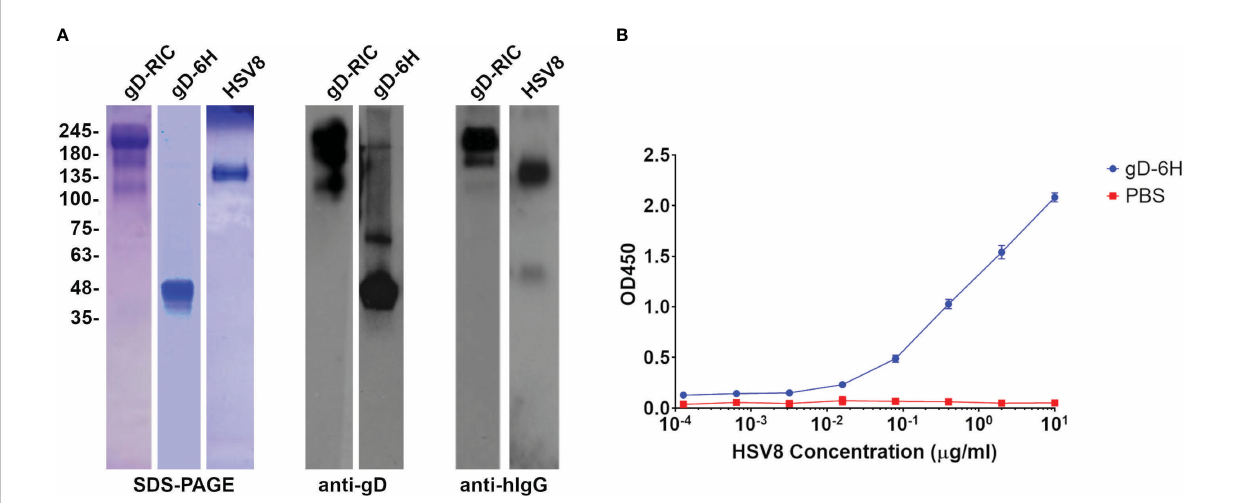
FIGURE 2 Puri fi cation of gD constructs and antibody binding assay. (A) SDS-PAGE and Western blots of the plant-made puri fi ed gD constructs. The gD samples were run under reducing conditions, whereas the antibody and RIC constructs were run under nonreducing conditions. The Western blots were probed with either HSV8 (for gD-6H) or H170 (for gD-RIC) to recognize gD, or with an anti-human IgG (H+L) HRP-conjugated antibody. (B) An ELISA was performed to test the binding between plant-made gD and HSV8. Puri fi ed gD was bound to the plate, probed with various concentrations of HSV8, and detected with anti-human IgG-HRP conjugate. Points represent mean OD450 ± standard deviation from two